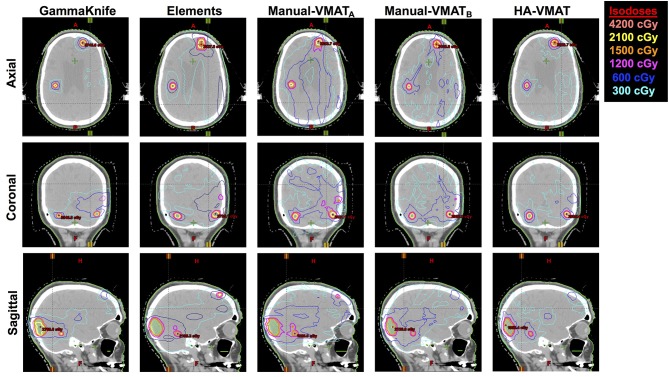
Axial, coronal, and sagittal cuts of patient #15 selected to visually demonstrate differences in dose distribution among the five different SRS plans.